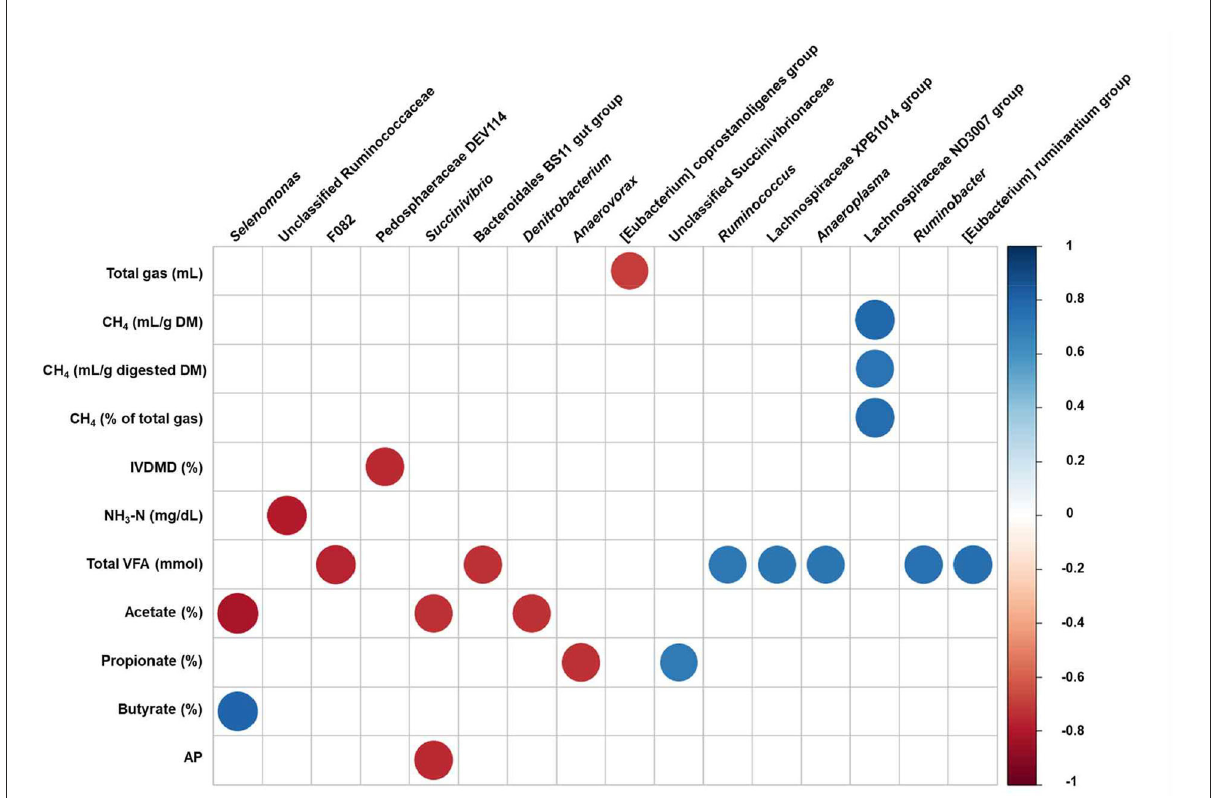
FIGURE5 Pearson’s correlation coefficients between the relative abundance of differentially abundant bacterial genera and fermentation and gas parameters affected by the red seaweed extract supplementation after 24h of in vitro incubation. Each row in the graph represents fermentation and gas parameters, each column represents a prokaryotic genera. Only strong significant correlation coefficients (| r | > 0.7, P < 0.05) are shown on the plot. CH 4 , methane; DM, dry matter; NH 3 -N, ammonia nitrogen; VFA, volatile fatty acid; AP, acetate to propionate; UCG, uncultured genus-level